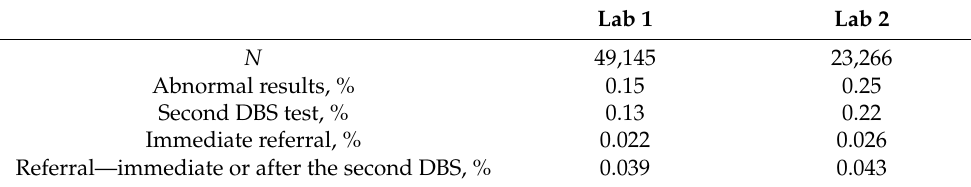
Table 3. Recall rates for each